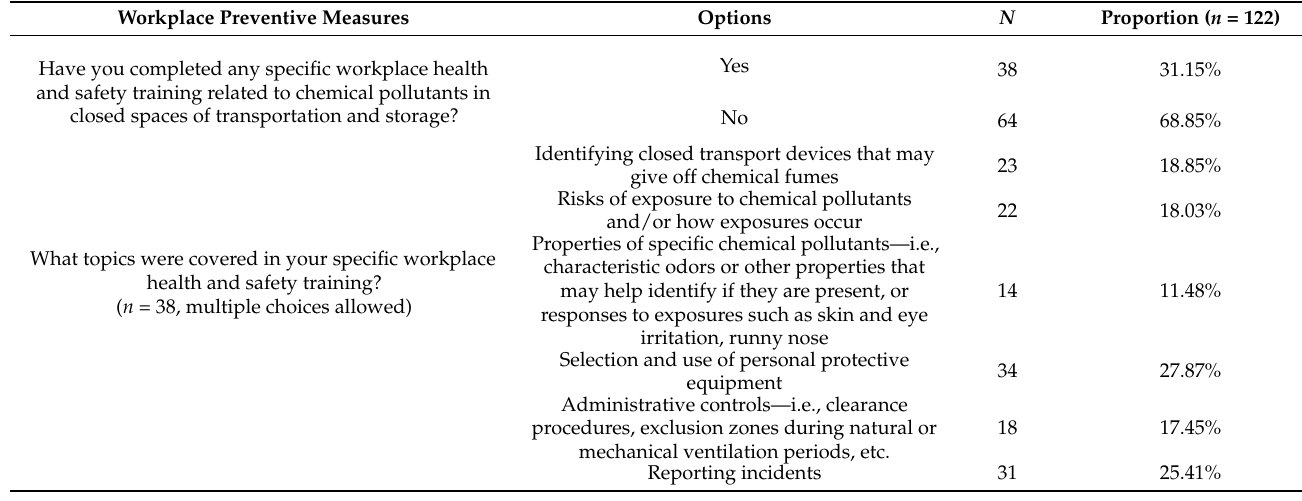
Table 5. Participation in specific workplace health and safety training related to chemical pollutants and the topics covered. Workplace Preventive Measures